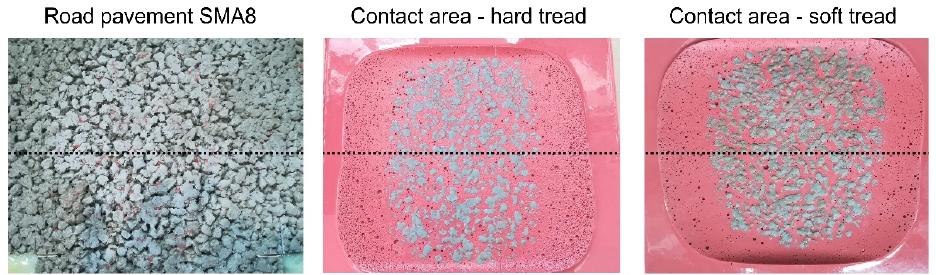
Figure 10. View of SMA8 pavement and contact area of HARD and SOFT treads.